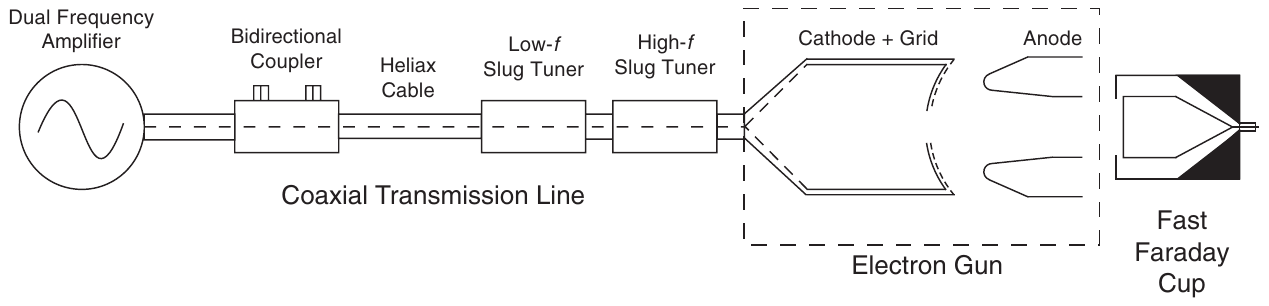
FIG. 2. Schematic diagram of the experimental setup for bunch length